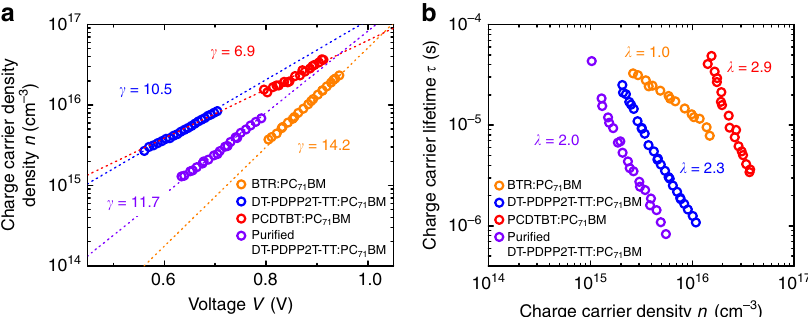
Fig. 5 Energy level measurements. a Dark work-function and LUMO/HOMO values of 1 µ m thick PCDTBT:PC 71 BM and original DT-PDPP2T-TT:PC 71 BM fi lms. b Thickness-dependent Fermi-level with different contacts of PCDTBT:PC consistent over 200 nm